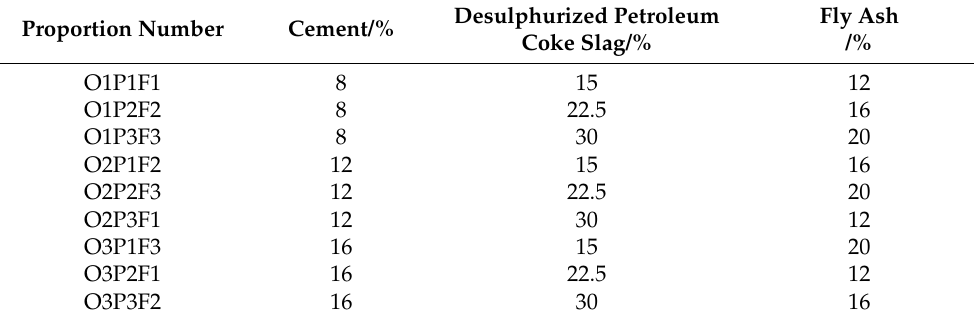
Table 5. Orthogonal experiment